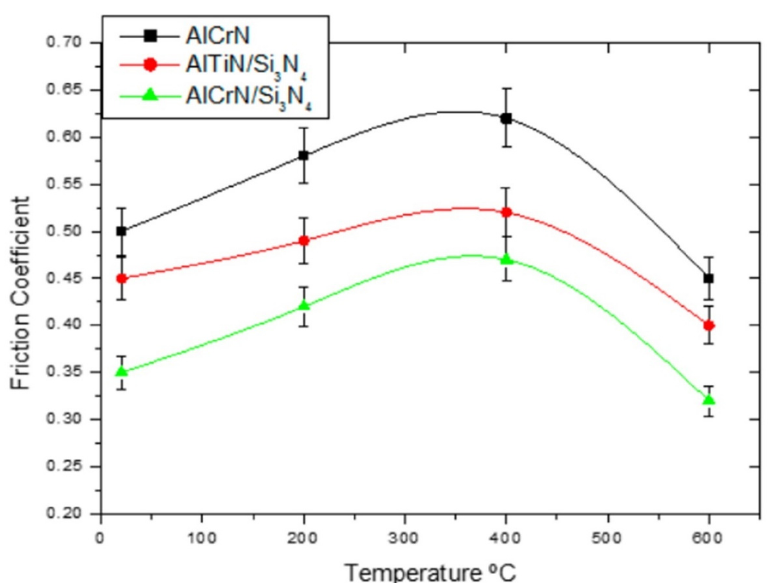
Figure 15. Friction coefficient of the AlCrN, AlTiN/Si 3 N 4 and AlCrN/Si 3 N 4 coatings at various temperatures [206].